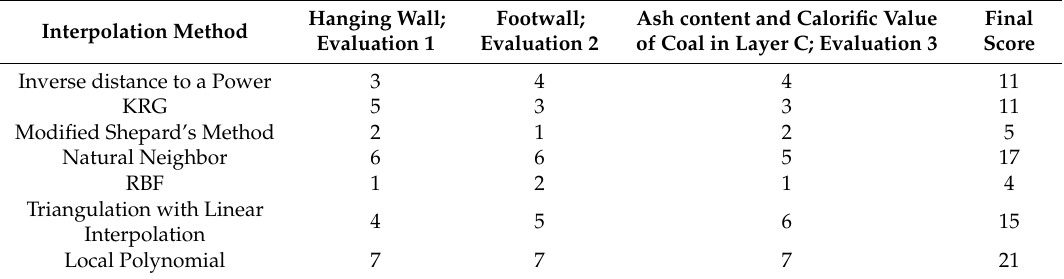
Table 4. Numerical evaluations of the interpolation methods available and chosen in software package Surfer ®